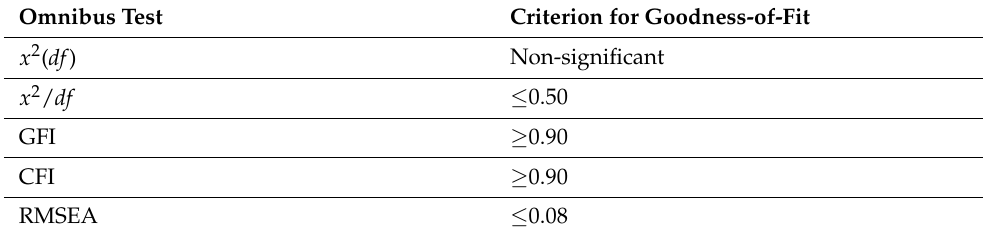
Table 1. Goodness-of-fit assessment.